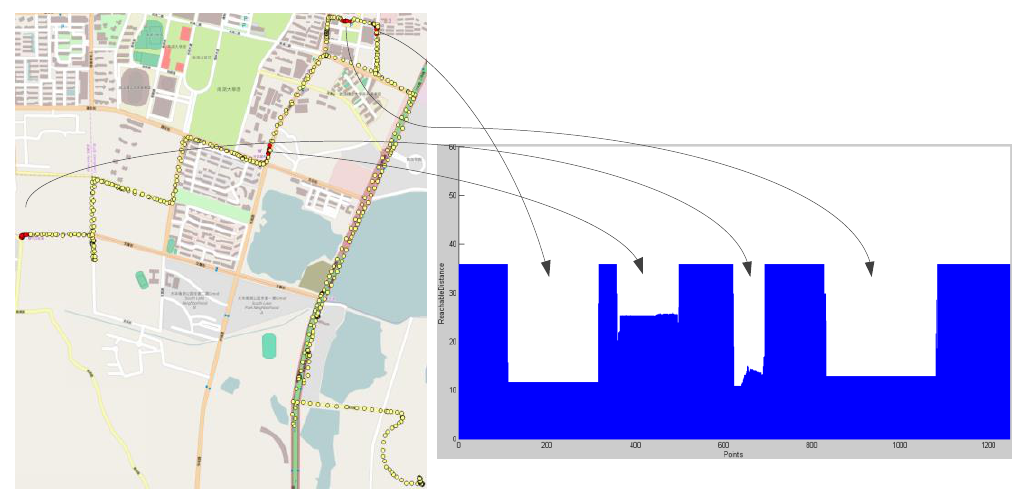
Figure 5. A trajectory from Dataset 2 and its reachability graph.